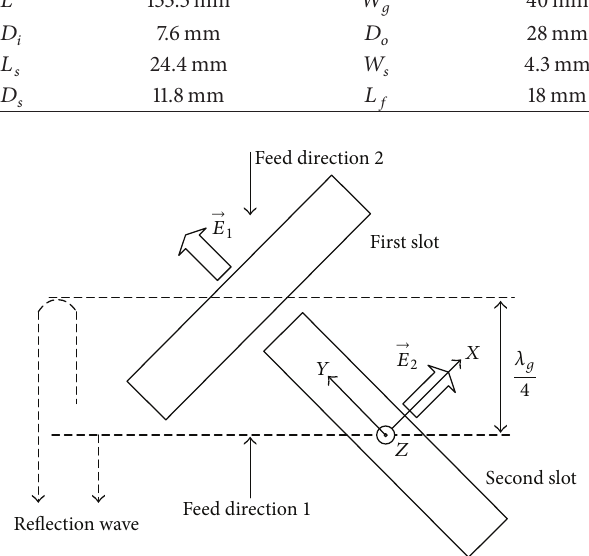
Figure 2: The adjacent perpendicular slot